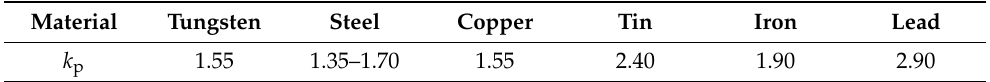
Table 1. Correction coefficient k p